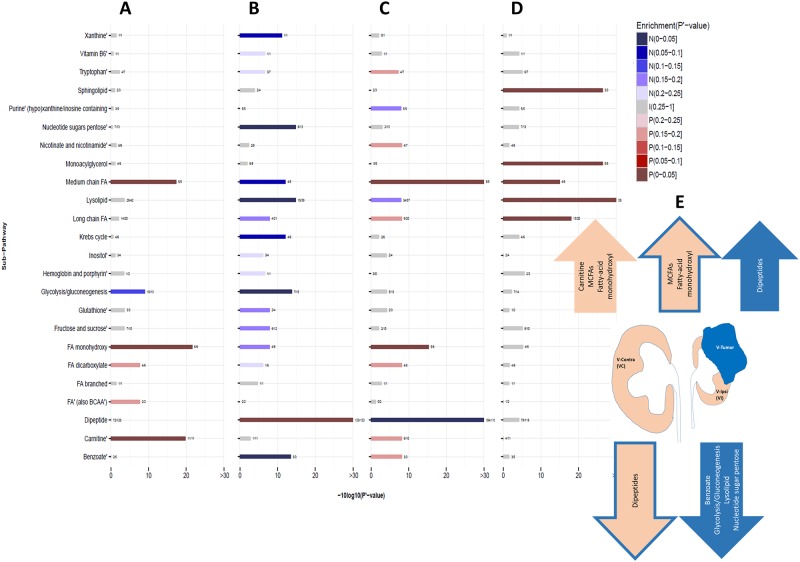
Metabolic sub-pathways enriched in pre-operative compensatory renal growth (CRG).The X-axis is the FDR adjusted p-value (p’-value) of the sub-pathway enrichment analysis, -10log10 transformed, and the Y-axis is the sub-pathway which the metabolites correspond to. In red shades are sub-pathways enriched in metabolites whose abundances are positively associated with CRG (“P” in the legend indicating positive), and in blue shades are sub-pathways enriched in metabolites whose abundances are negatively associated with CRG (“N” in the legend indicating negative). All other sub-pathways (indicated with “I” for invariant in the legend) are colored in gray. Panels A and B describe OPLS fit to metabolite abundances in benign and tumor tissue, respectively, with pre-operative CRG as response. Panel C describes OPLS fit to benign/tumor metabolite abundance fold-change with pre-operative CRG as response. Panel D describes OPLS fit to metabolite abundances in benign tissue with LT-CRG as response. Panel E describes a sample of sub-pathways enriched with metabolites strongly associated with pre-operative CRG. Arrows facing up represent sub-pathways enriched with metabolites with a positive association and arrows facing down represent sub-pathways enriched with metabolites with a negative association. The pink arrow represents sub-pathways enriched with metabolites within benign tissue, the blue arrows represent sub-pathways enriched with metabolites within the tumor tissue, and the pink arrows with the blue outline represent sub-pathways enriched with metabolites from the benign/tumor metabolite fold-change.